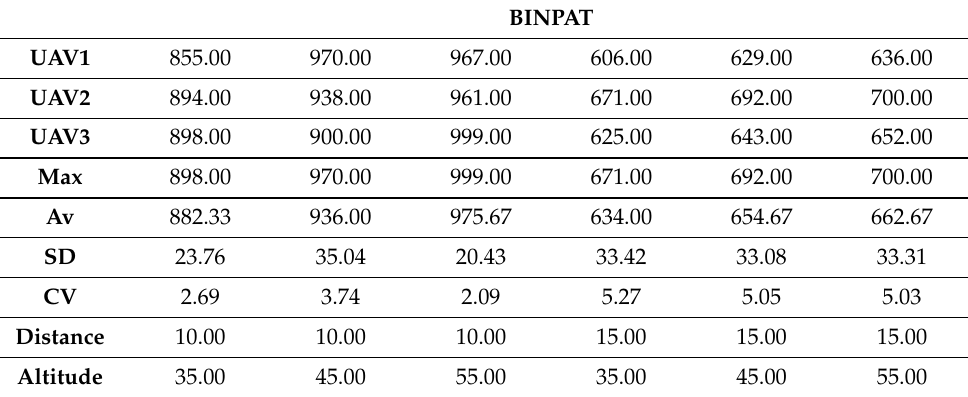
Table A9. Time results using the POWELL-BINPAT algorithm and three UAVs in a long-track